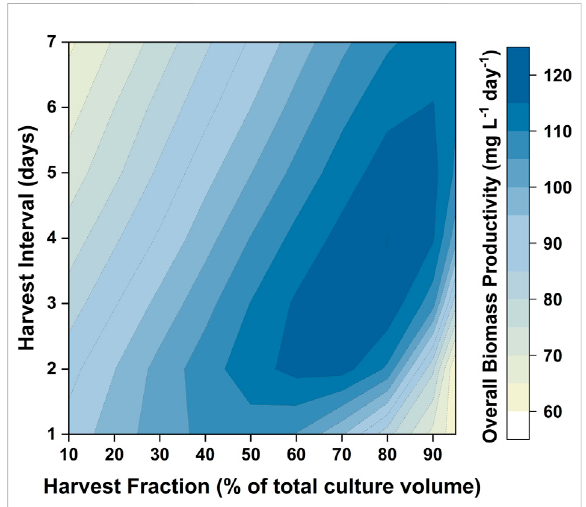
FIGURE 9 Contour showing model predictions of biomass productivity in repeated-batch cultures of P. tricornutum with different harvest intervals and harvest fractions. Simulations were run based on the 5 L fl at-panel PBRsetup withsuf fi cient nitrogen. Thecultures were initially run in the batch mode for 8 days, followed by four havest